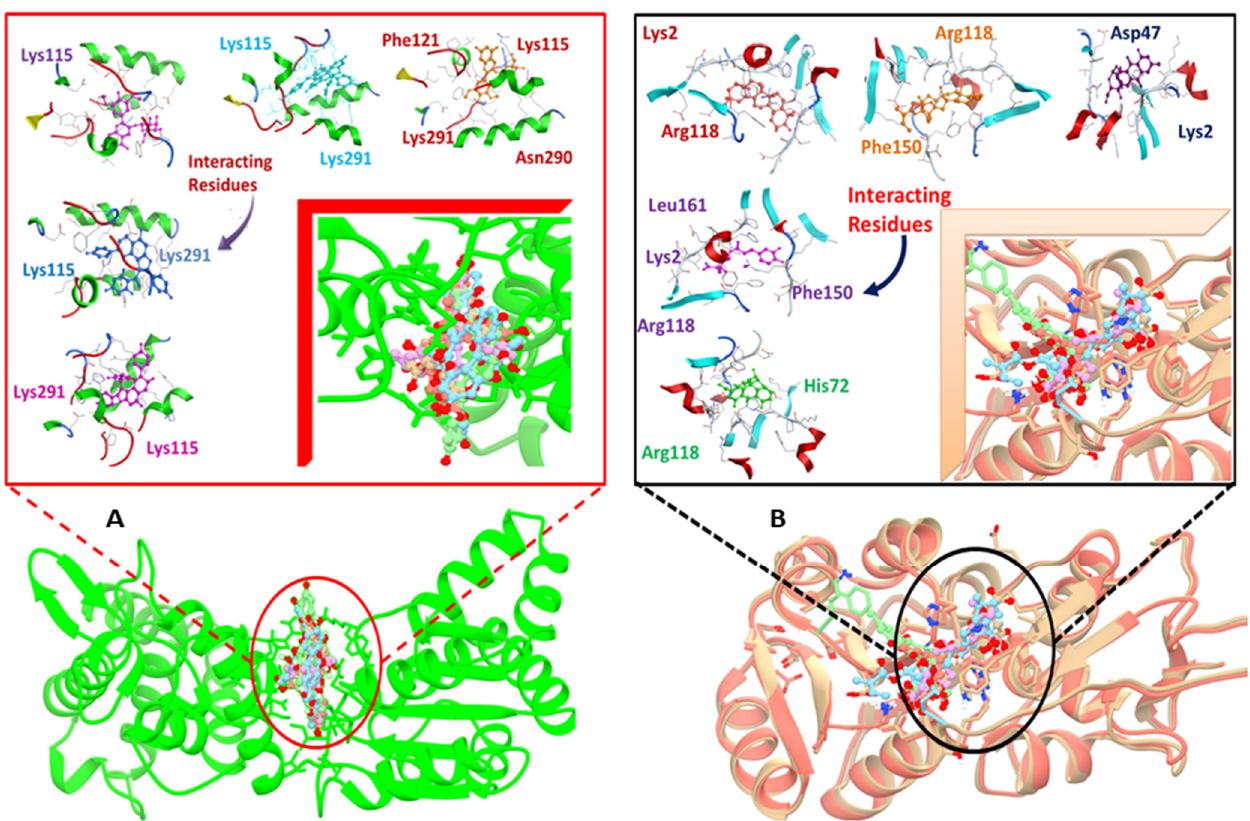
Figure 3. Docked complexes indicating, in detail, the interacting residues of the DNaA ( A ) and TCR ( B ) target proteins.